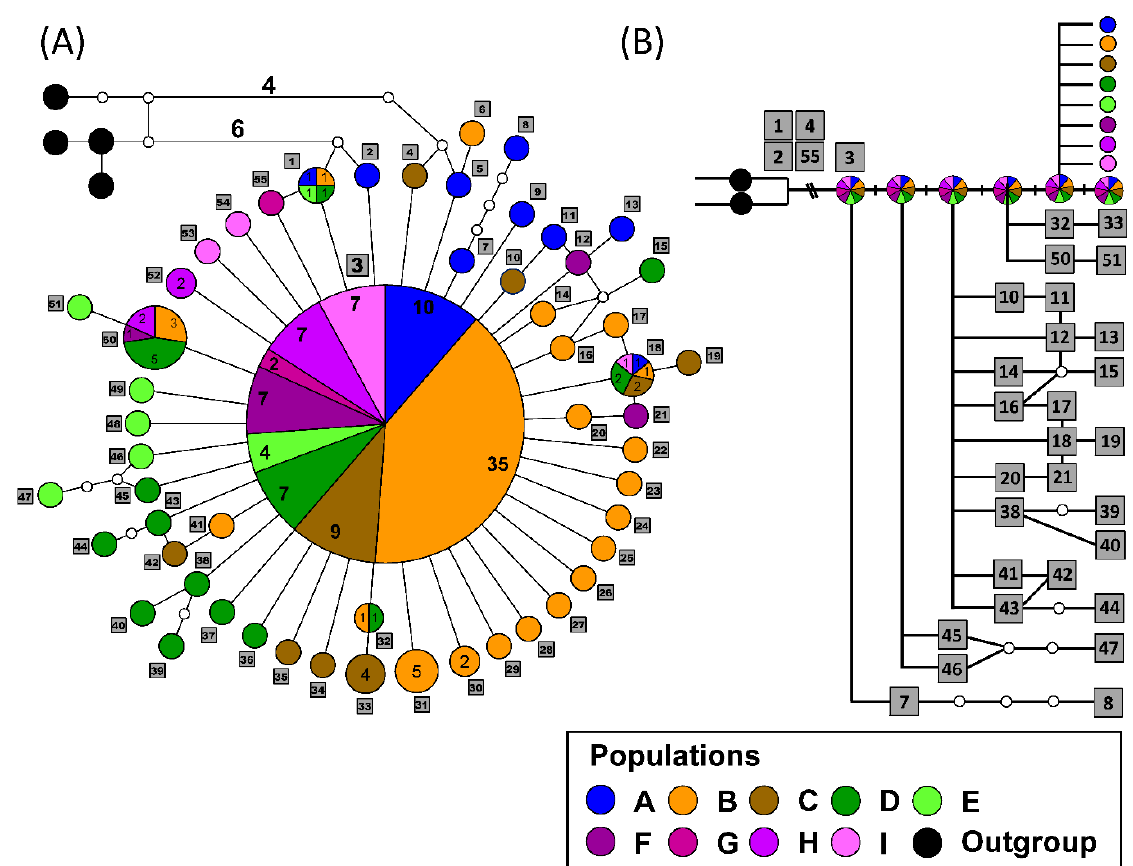
Figure 3. Haplotype network ( A ) and the possible evolution processes of ancestral and derived haplotypes according to the DELTRAN optimization ( B ) of the hilly lineage of NSC based on the COI gene. Populations are represented by different colors referring to the information given in Figure 1. Four individuals from the montane lineage are rooted. Each circle represents a haplotype, and the circle size is proportional to the number of individuals. The smallest circle corresponds to one individual, and the number of individuals of each population is marked on the shared haplotypes. The serial numbers of haplotypes were labeled in grey squares according to the population order from A to I.